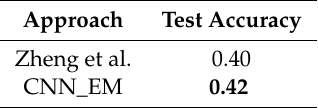
Table 5. Comparison of our scores against the results reported in [30], when evaluated on the IEMOCAP Database [44]. For comparison purposes we evaluated our method on the same set of target classes as in [30], which are : excitement , happiness , frustration , neutral and surprise . We follow a similar evaluation process as reported by Zheng et al, by choosing randomly 80% utterances of each emotion classification to construct the training dataset, the other 20% utterances for